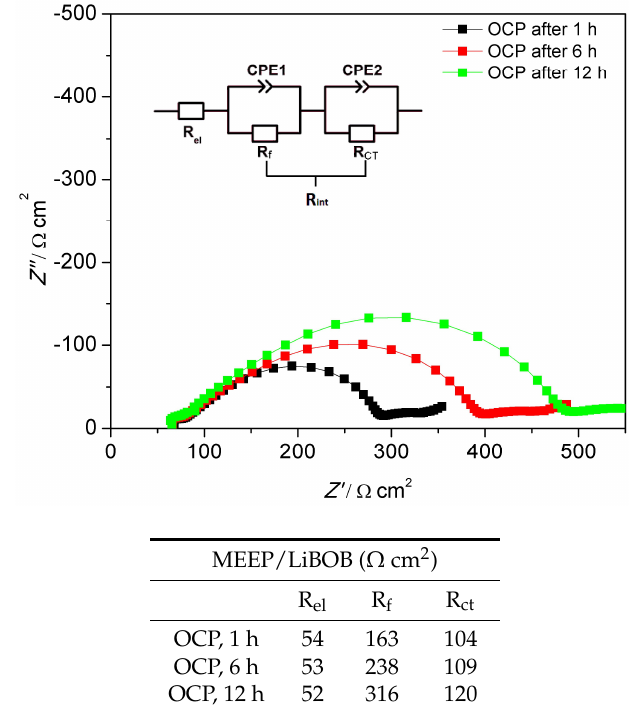
Figure 10. Impedance spectra of Li|MEEP/LiBOB|Li at 60 °C after 1, 6, and 12 h under OCP. The table lists the corresponding R el , R f , and R CT at different stages. R el is the electrolyte bulk resistance and R int is the interface resistance, which consists of R f and R CT .